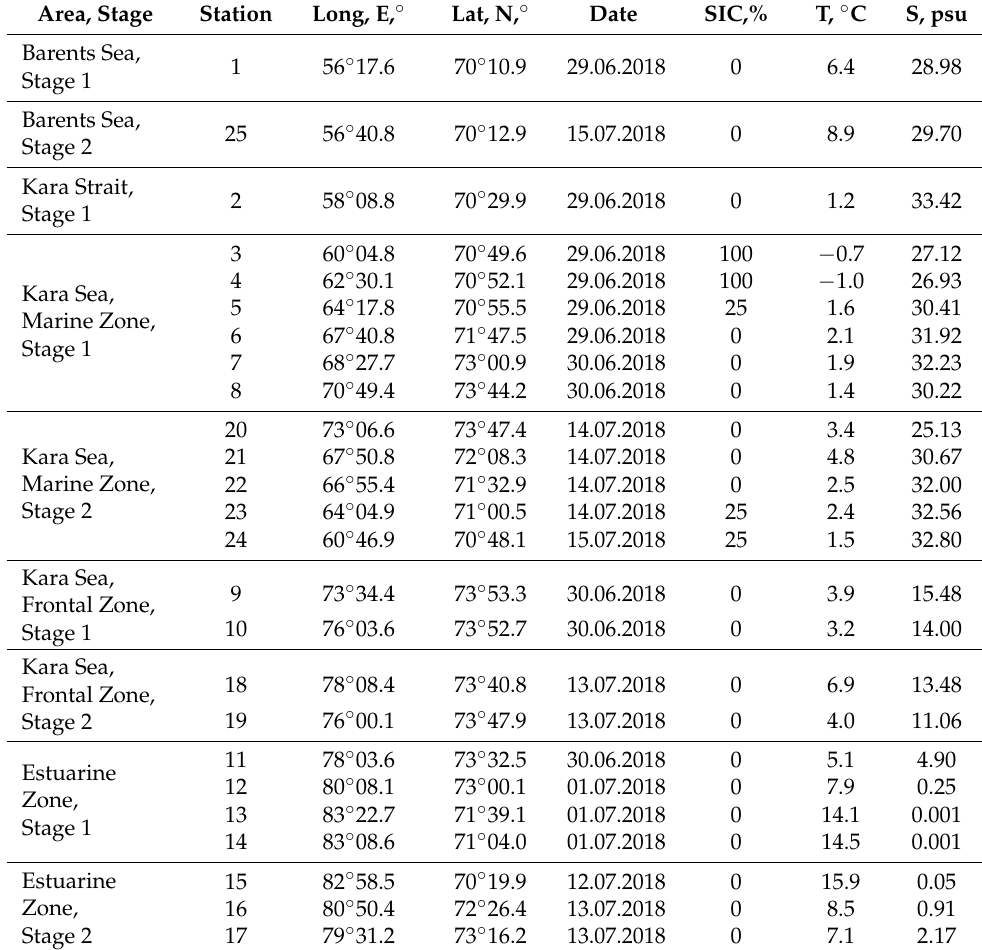
Table 1. Physical properties of the sampling locations in the Barents and Kara seas from June 29 to July 15, 2018: longitude (Long) and latitude (Lat), sea ice concentration (SIC), surface temperature (T), salinity (S).